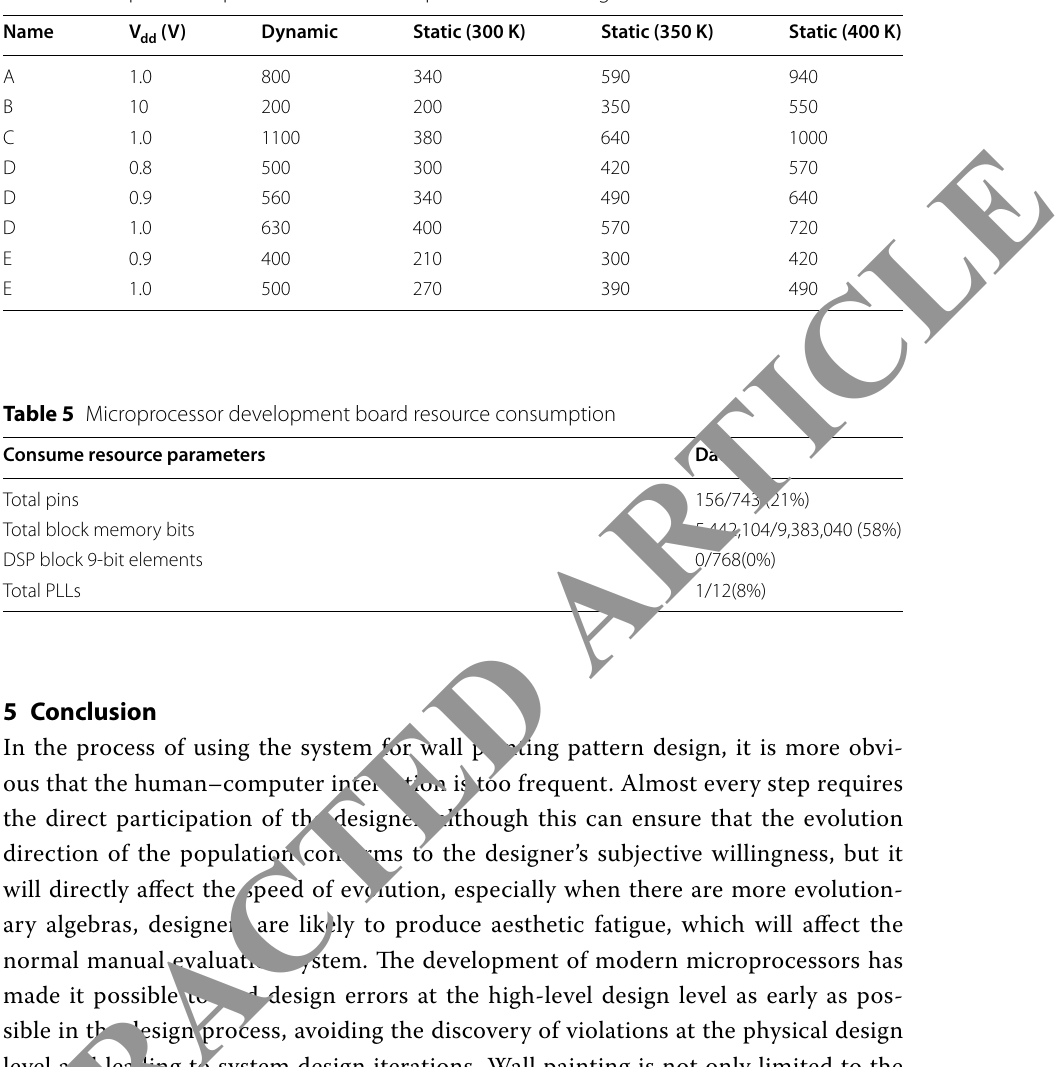
Table 4 Comparison of power at different temperatures and voltages